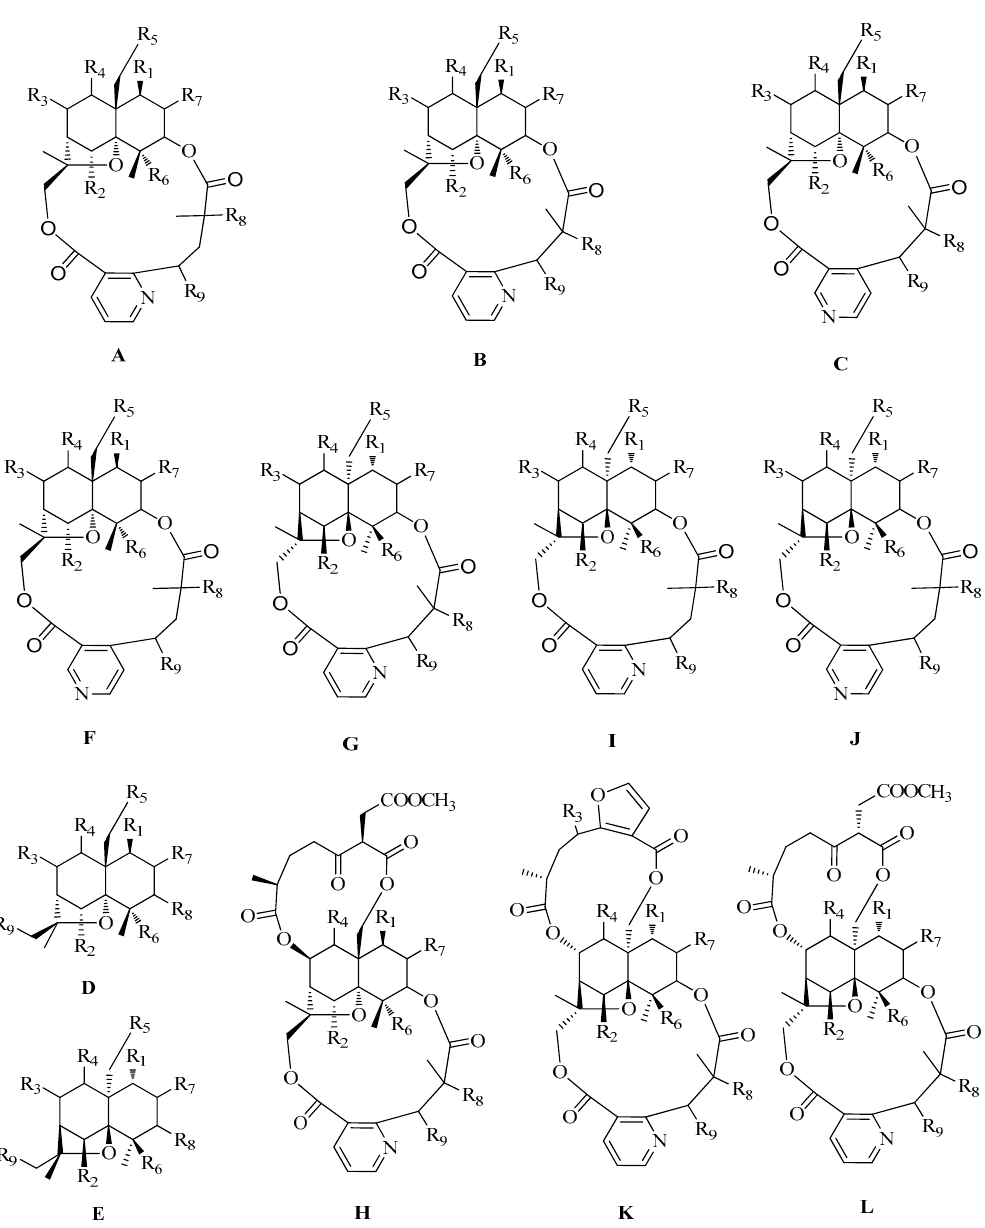
Figure 1. Twelve types ( A – L ) of dihydroagarofuran sesquiterpenoid skeletons.